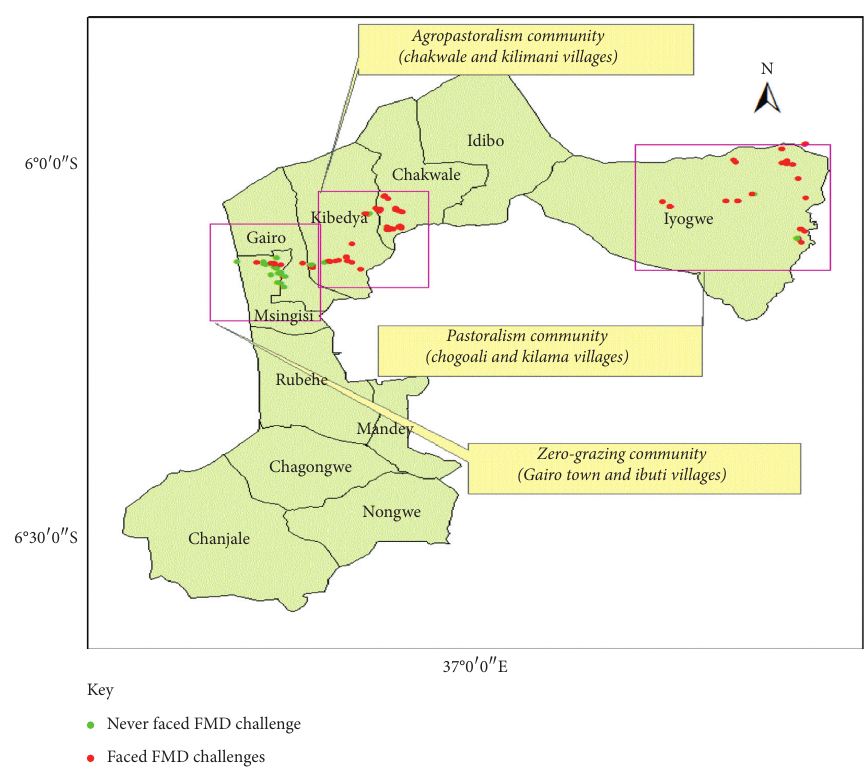
Figure 2: Spatial distribution of FMD surveyed households in the Gairo district. Table 1: Frequencies of livestock keepers who have already faced FMD